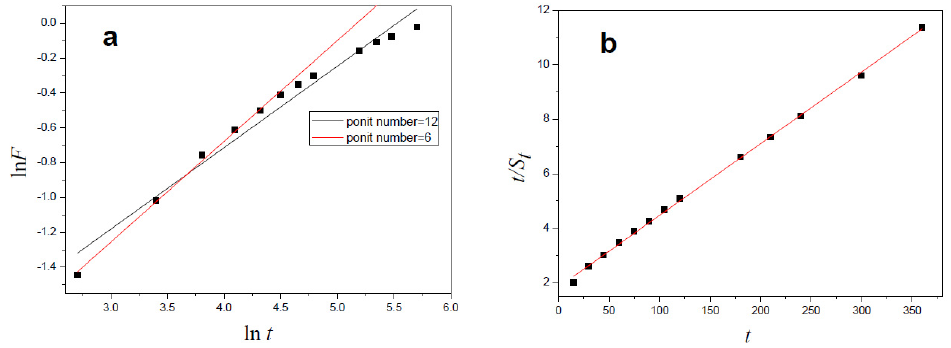
Figure 6. Swelling kinetic curves fitted using Fickian diffusion equation ( a ) and Schott second-order dynamic equation ( b ).